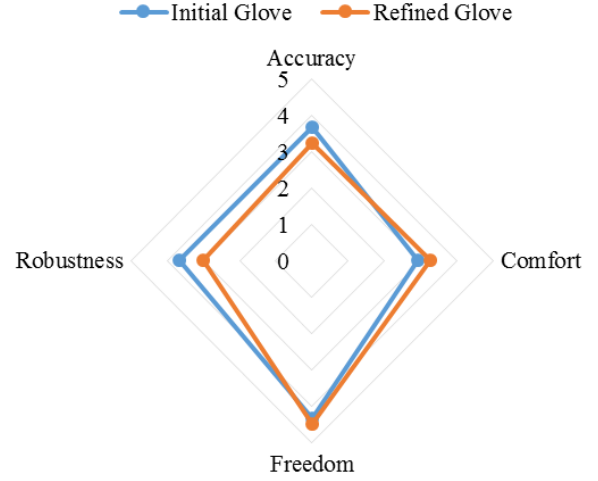
Figure 3. Evaluation